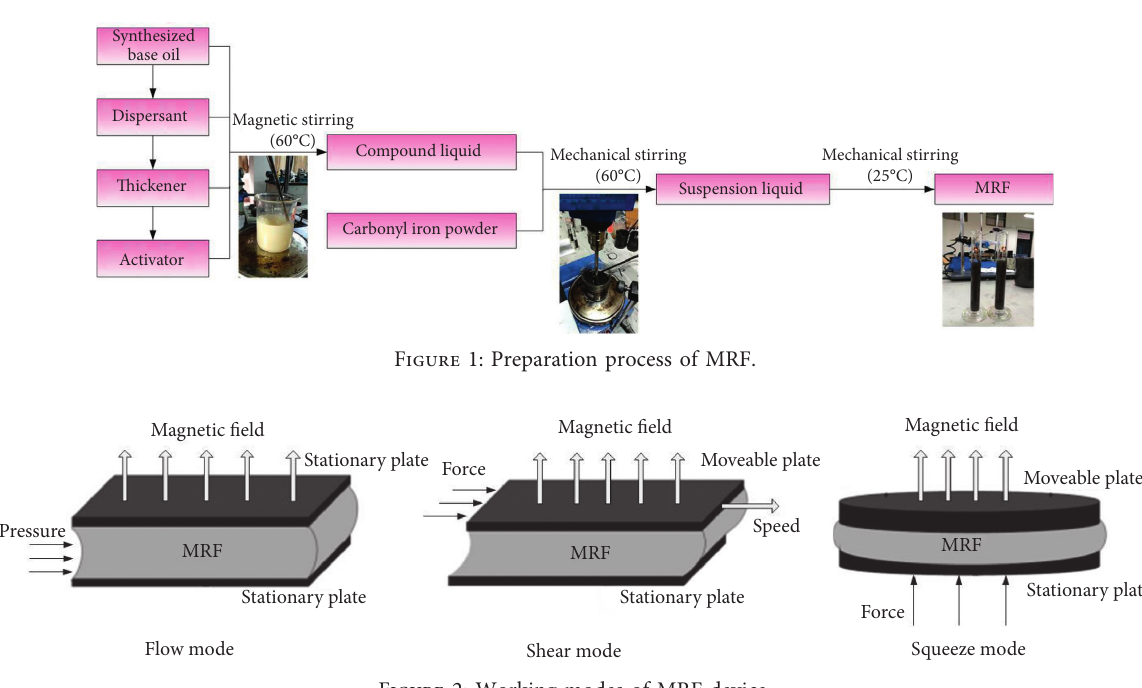
Figure 2: Working modes of MRF